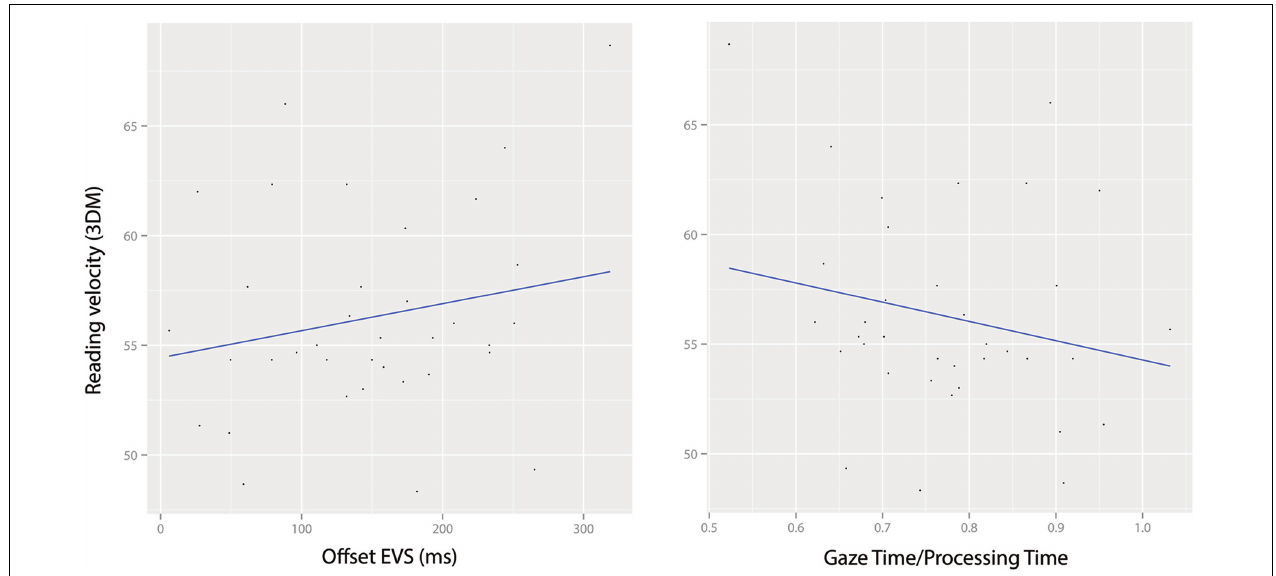
FIGURE 4 | Reading velocity (measured by 3DM, maximum 75 words) as a function of Offset EVS (left) and GT/PT (right). Subject means are